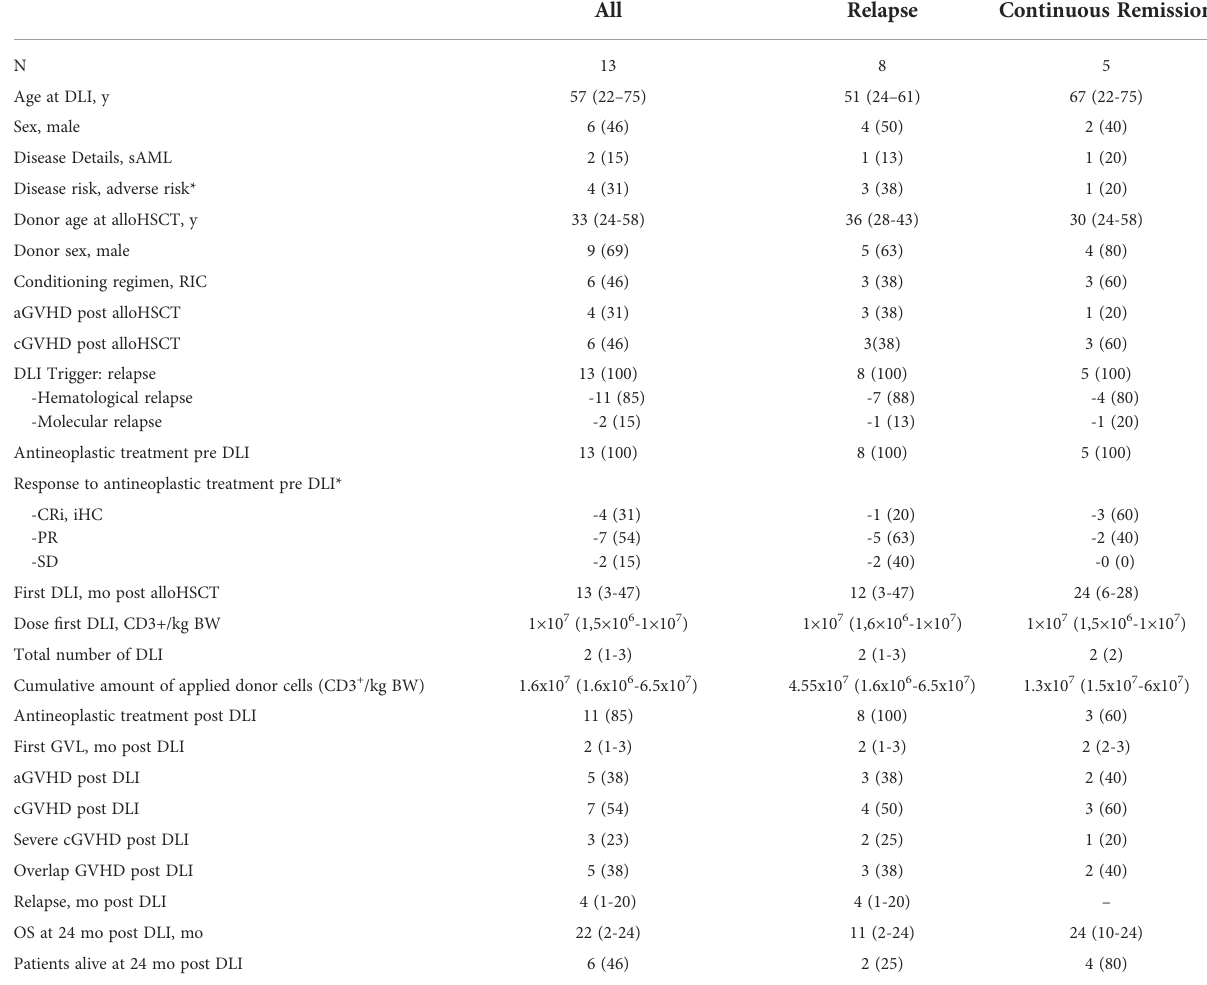
TABLE 1A Cohort overview and response to